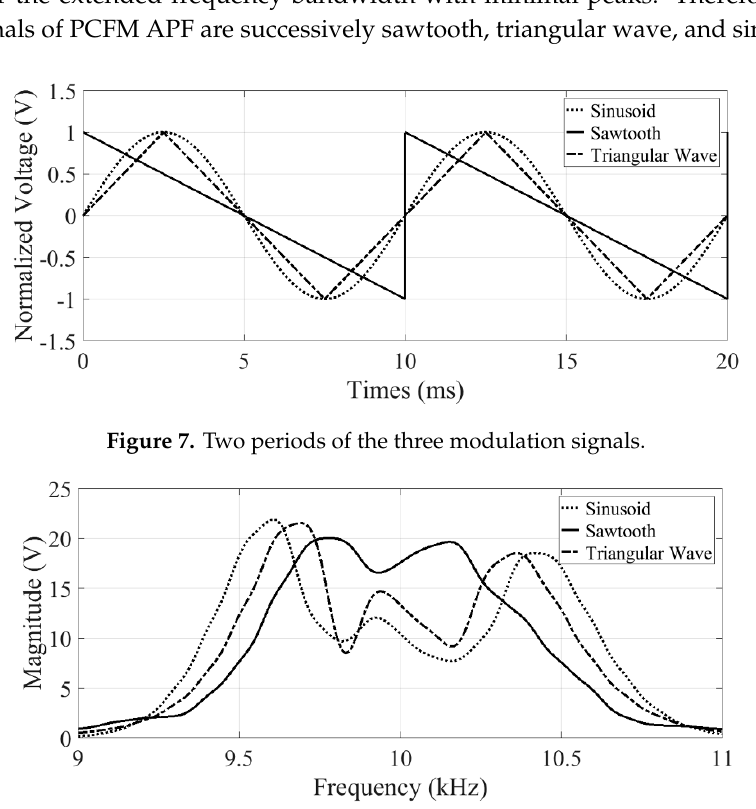
Figure 8. The source DM voltage v DMS spectra of the PCFM APF with different modulation signals ( ∆ f c = 500 Hz).